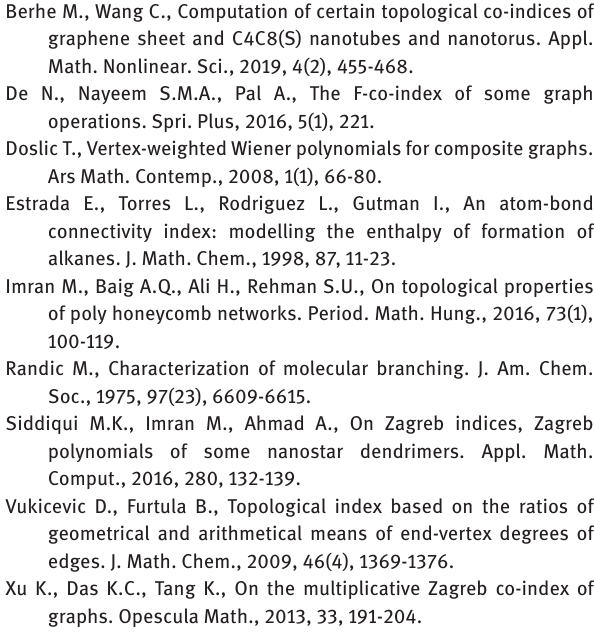
R G ( ) for α = 1,−1, (b) α